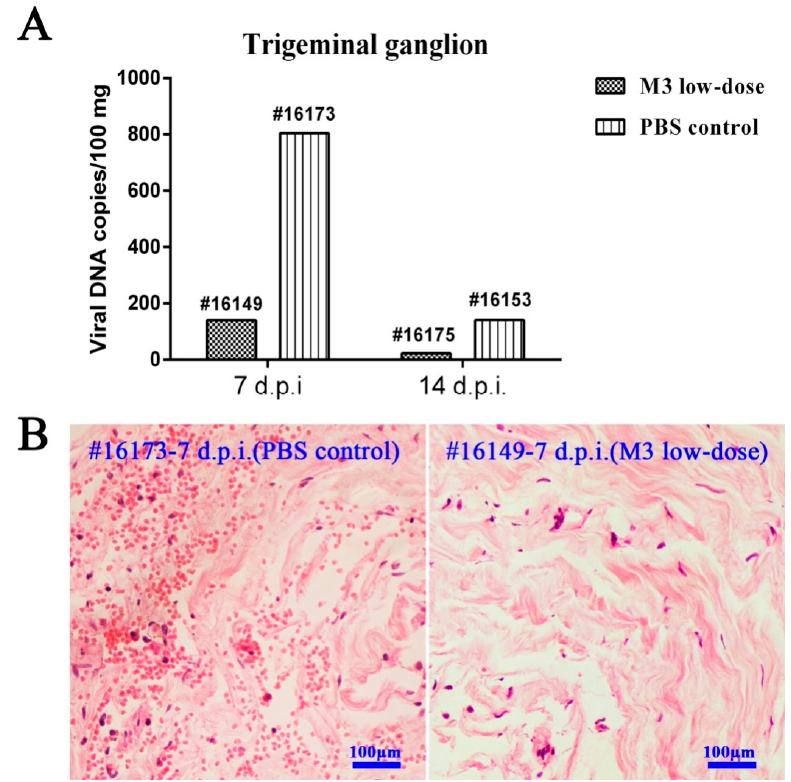
Figure 6. The immunity induced by M3 limits the viral entry into the TG. ( A ) M3 distribution in the TG on days 7 and 14, post-infection; ( B ) Pathological features of the TG of a PBS control macaque (#14139) and an M3-immunized macaque (#16149) on day 7, post-infection; scale bars = 100 μ